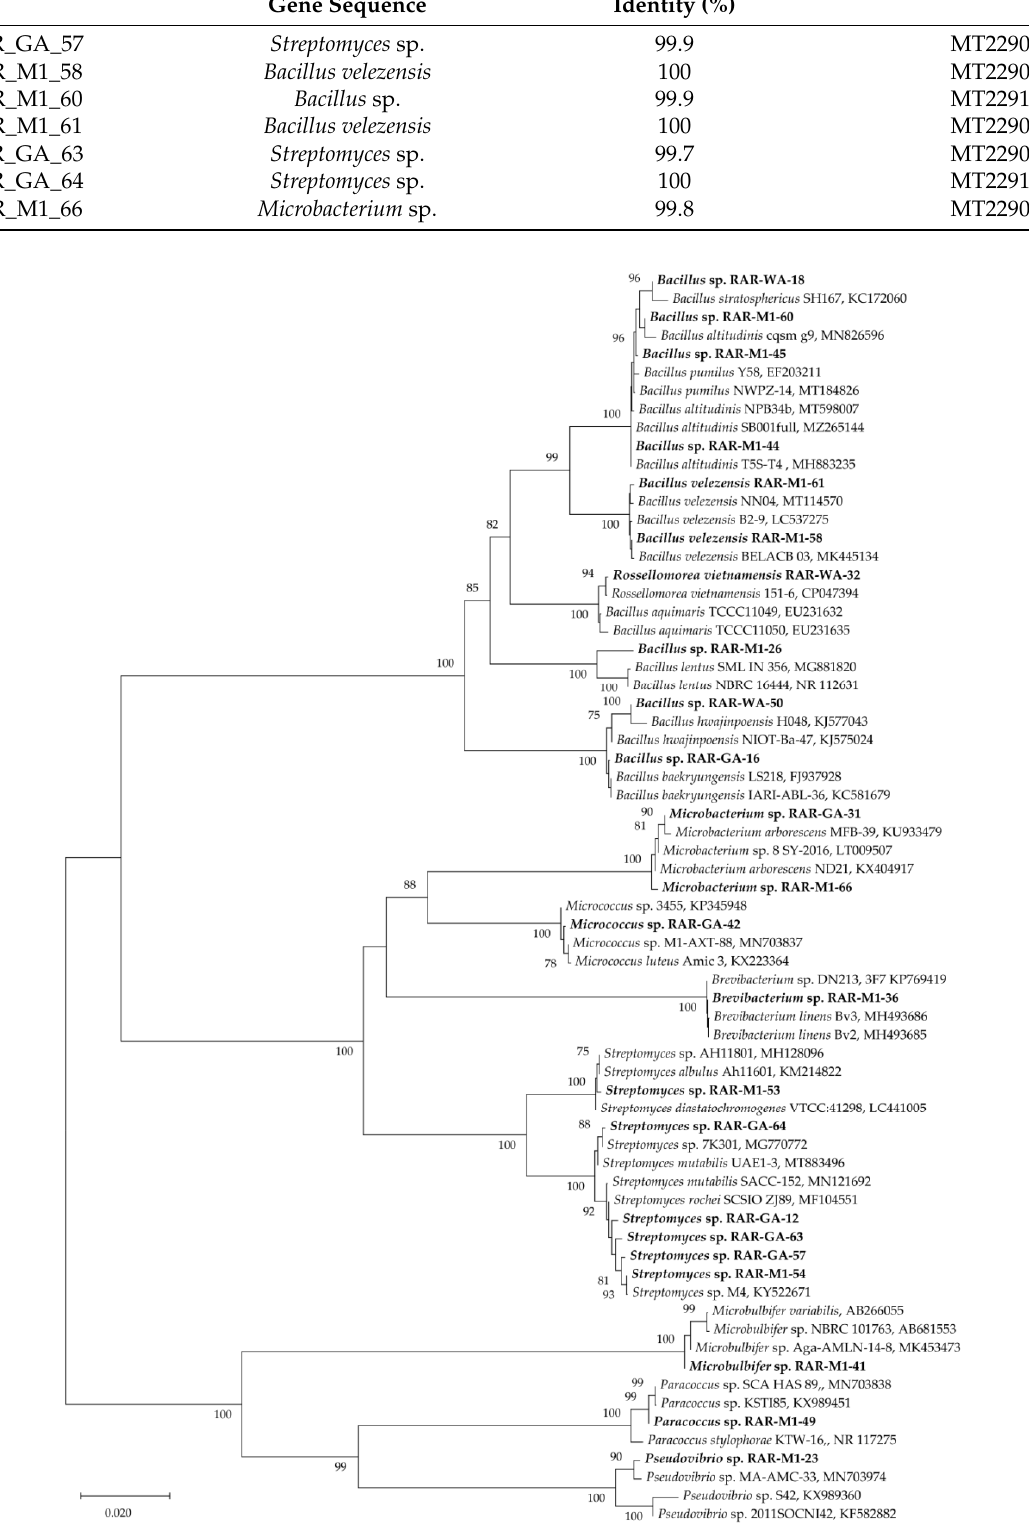
Figure 2. Phylogeny of 16S rRNA gene sequences of the endophytic bacteria in our study (bold letters) and from the National Center for Biotechnology Information (NCBI) GenBank. Bootstrap support values of branches greater than 75% are given above the corresponding branches .